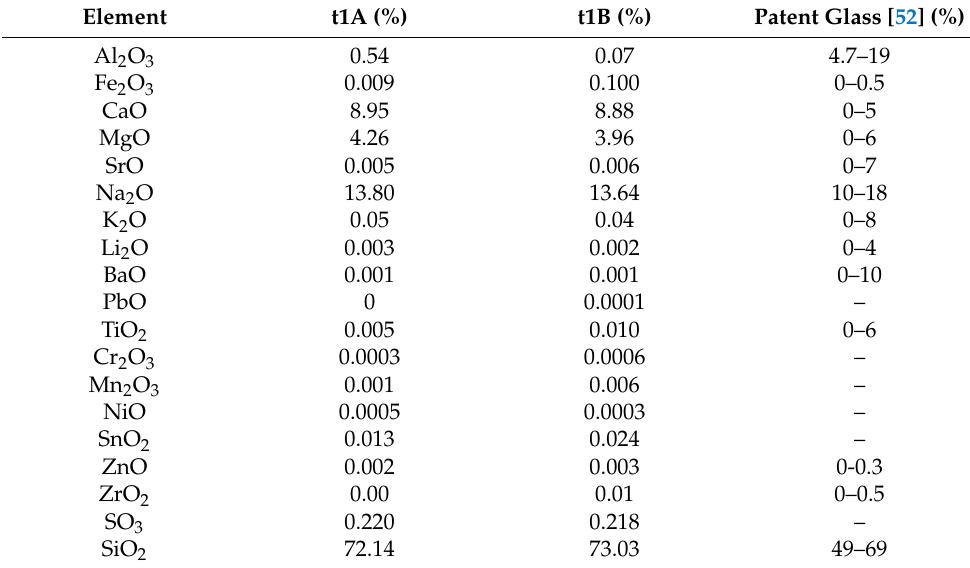
Table 6. Chemical analysis by ICP-EOS, results in weight